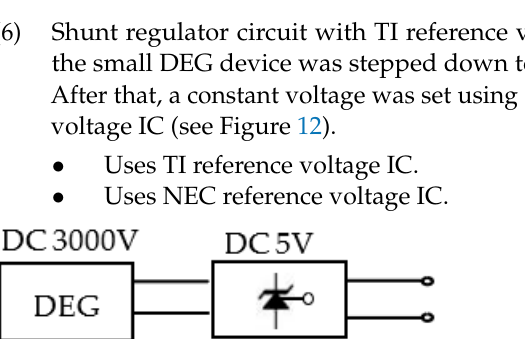
Figure 11. Circuit using Zener diode.